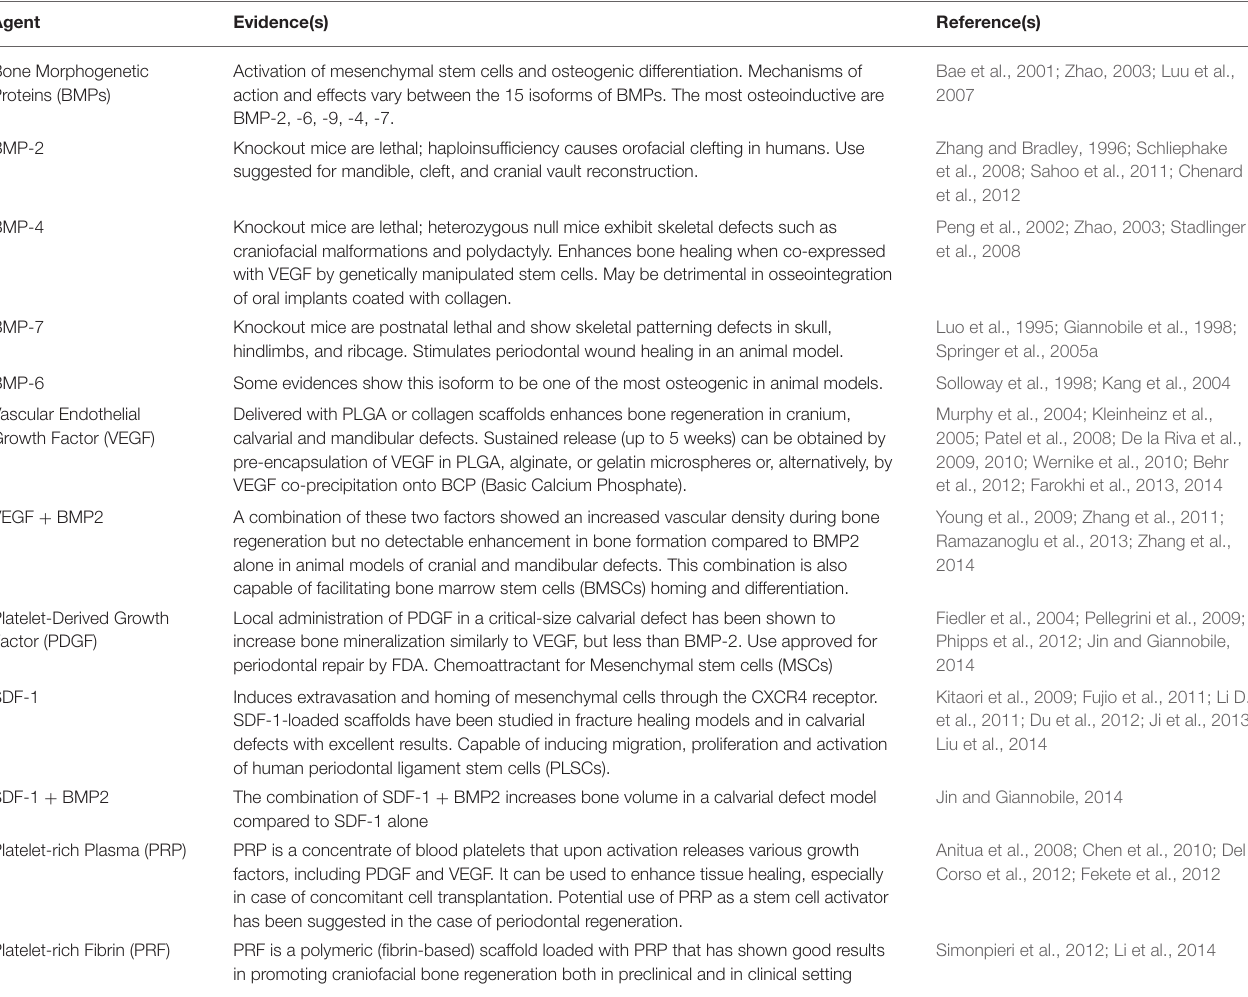
TABLE 2 | Growth factors and other agents used for local activation and/or mobilization of stem cells in craniofacial and bone